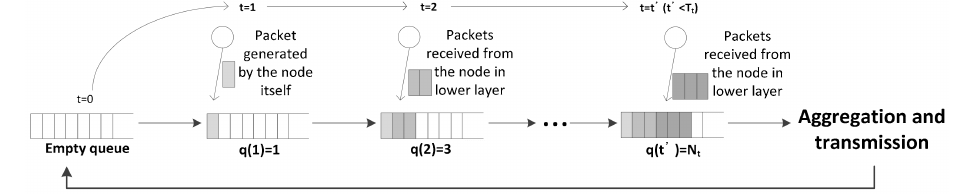
Figure 3. Packet aggregation occurs since the number of packets is equal to or greater than N t .